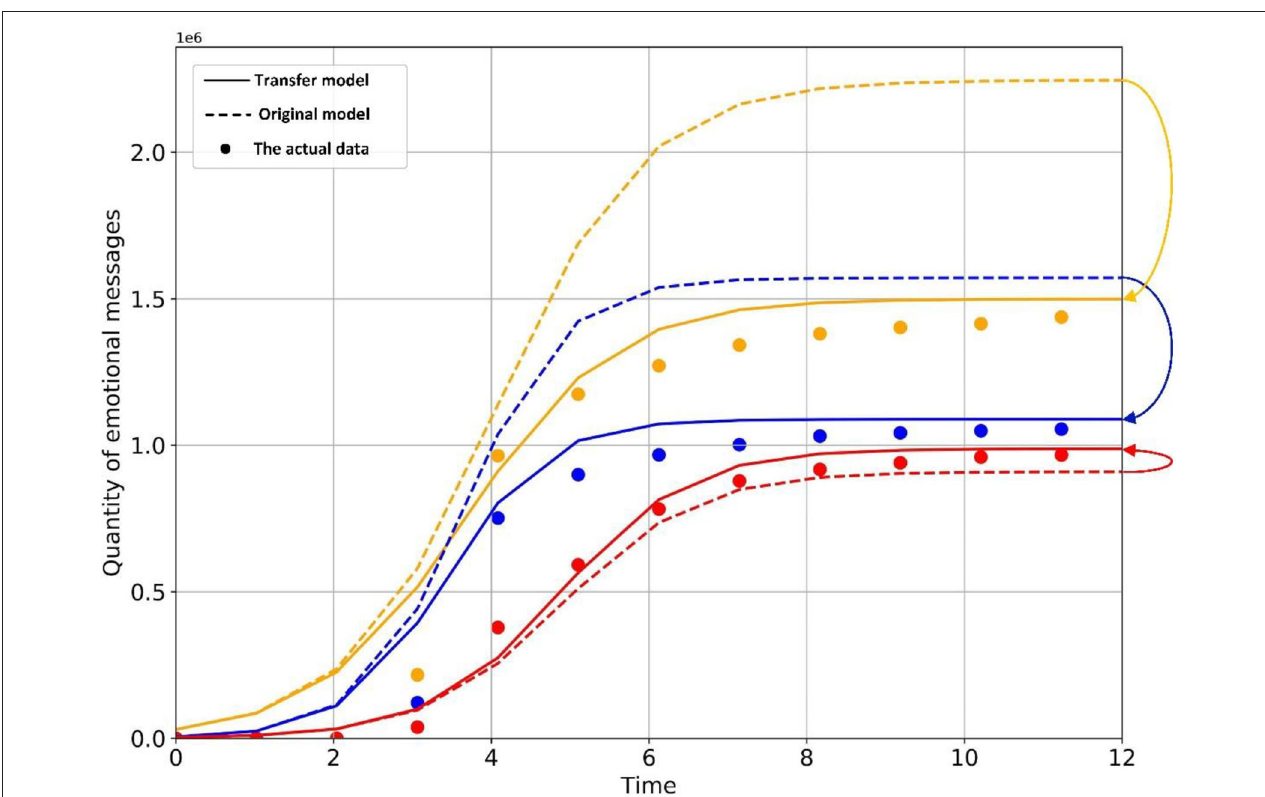
FIGURE 15 | The actual data and fitting